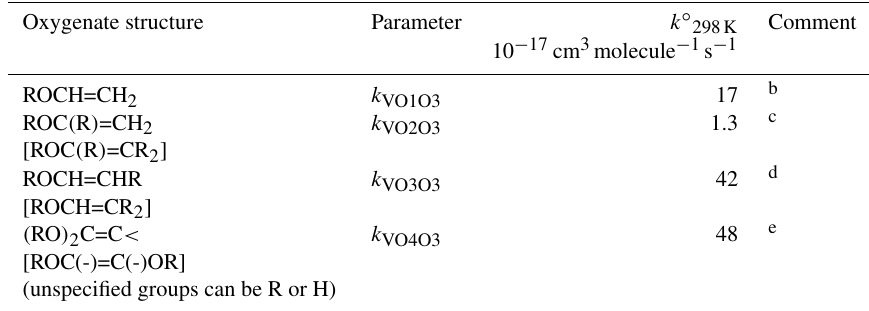
Table 8. Reference rate coefficients for O 3 addition to vinylic ethers a .